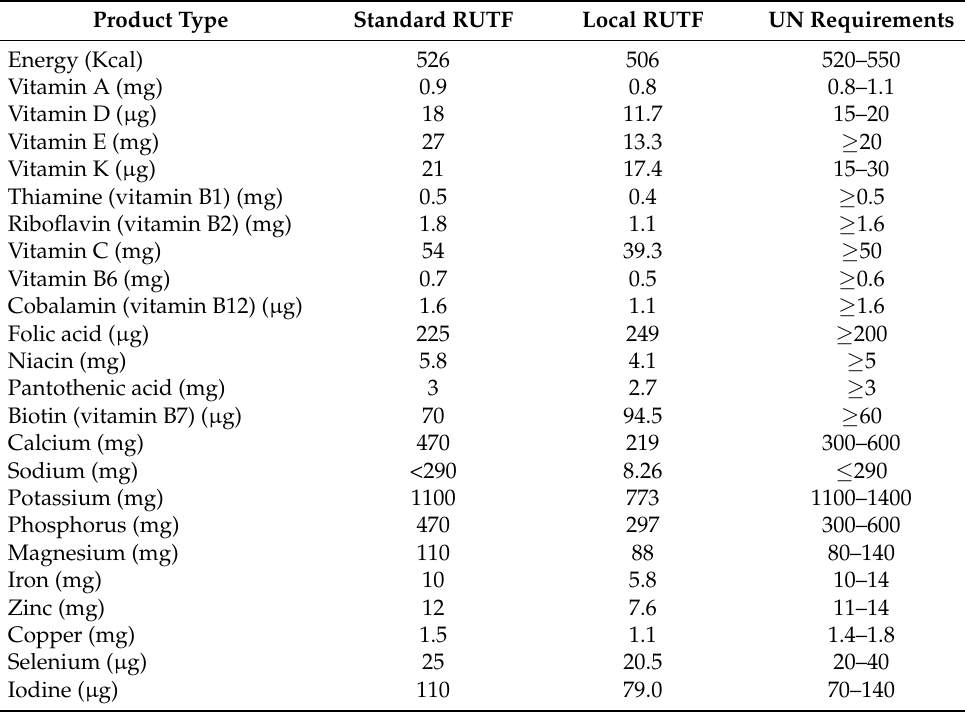
Table 1. Micronutrient composition of RUTF per 100